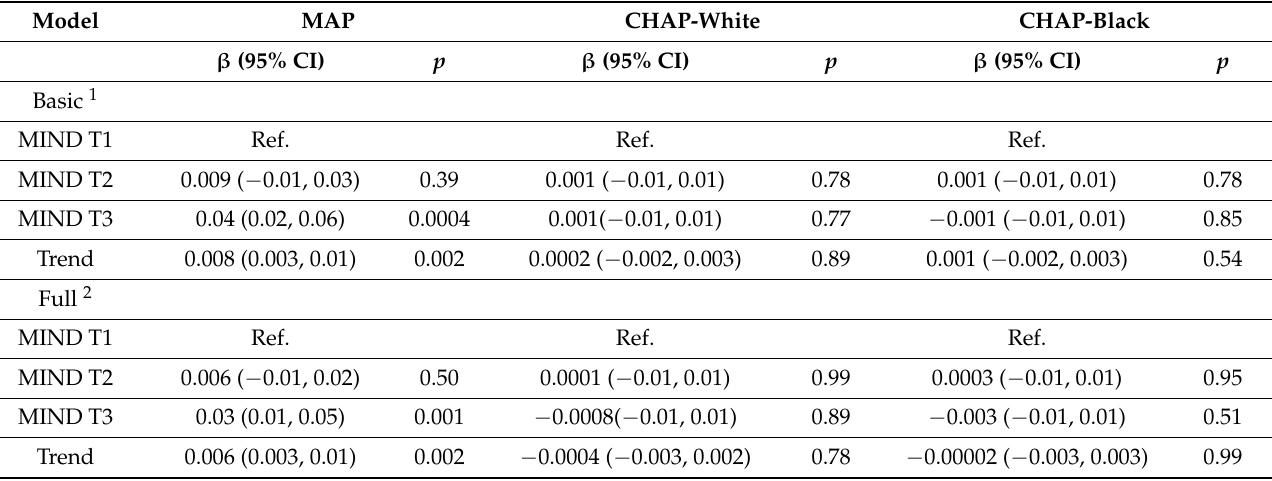
Table 3. MIND score and cognitive decline.